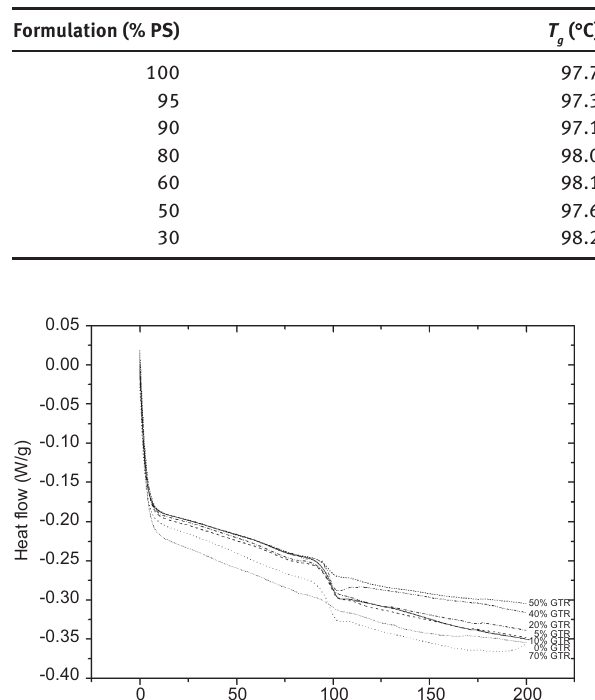
Table 1 Calorimetric parameters of mixtures of PS/GTR for particle sizes < 200 μ m.